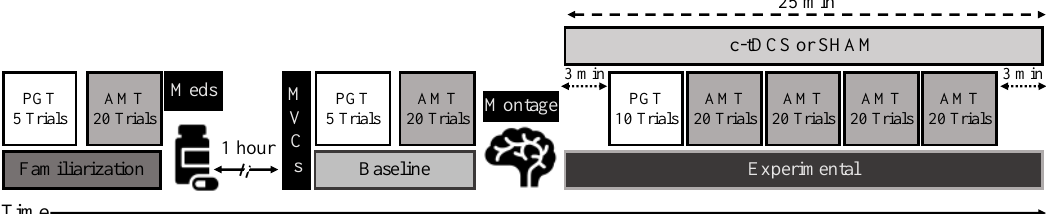
Figure 1. Schematic representation of the experimental protocol that included a familiarization (5 precision grip task (PGT) trials; 20 arm movement task (AMT) trials), medication ingestion followed by 1 h of rest, 3 maximal voluntary contraction (MVC) trials, a Baseline condition (5 PGT trials; 20 AMT trials), cerebellar transcranial direct current stimulation (c-tDCS) montage placement, and an Experimental condition (25 min of either c-tDCS or SHAM stimulation concurrent with 10 PGT trials and 4 blocks of 20 AMT trials).